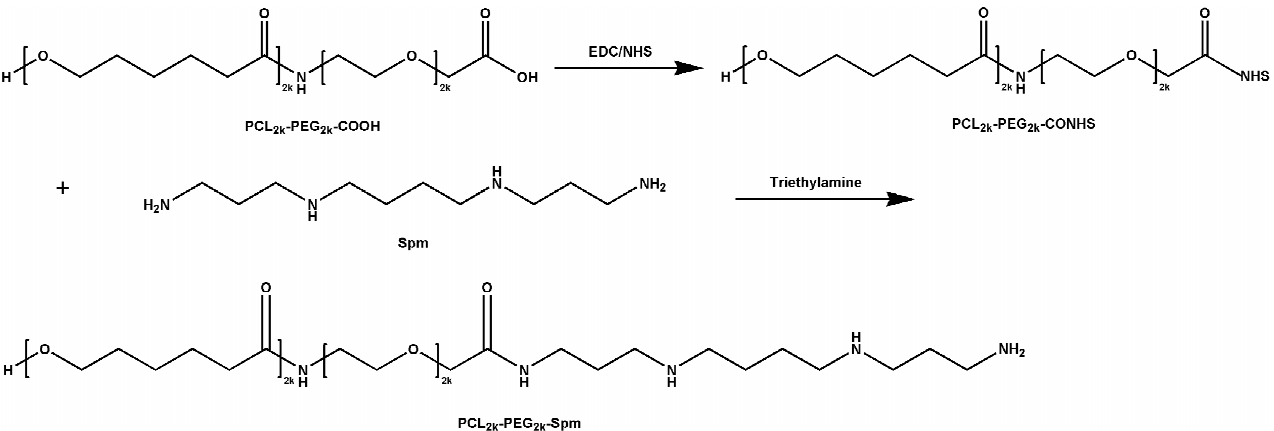
Figure 1. Synthesis route to Spm-PEG-PCL copolymer.